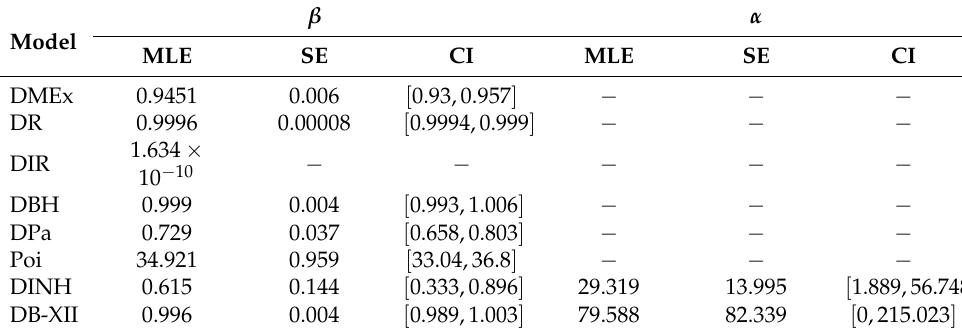
Figure 14. Non-parametric visualization plots for COV-P data. Figure 14 . Non-parametric visualization plots for COV-P data. Table 14. The MLE, SE, and CI for COV-P data. Table 14 . The MLE, SE and CI for COV-P data.